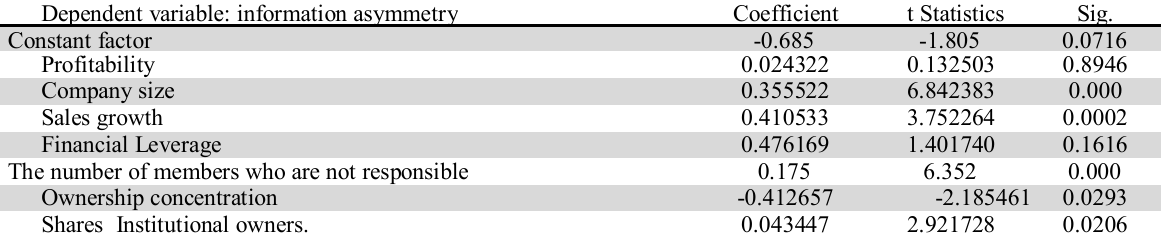
Results of fitted